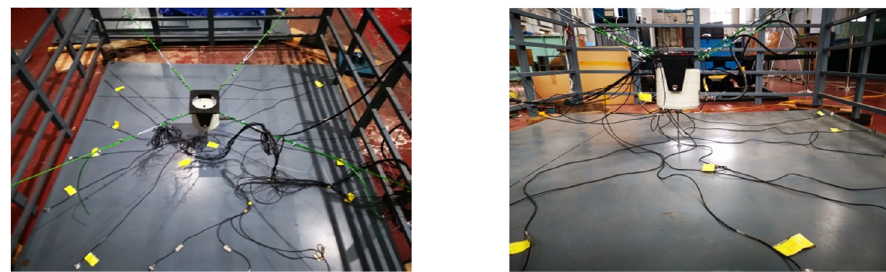
Figure 4: Arrangement of vibration